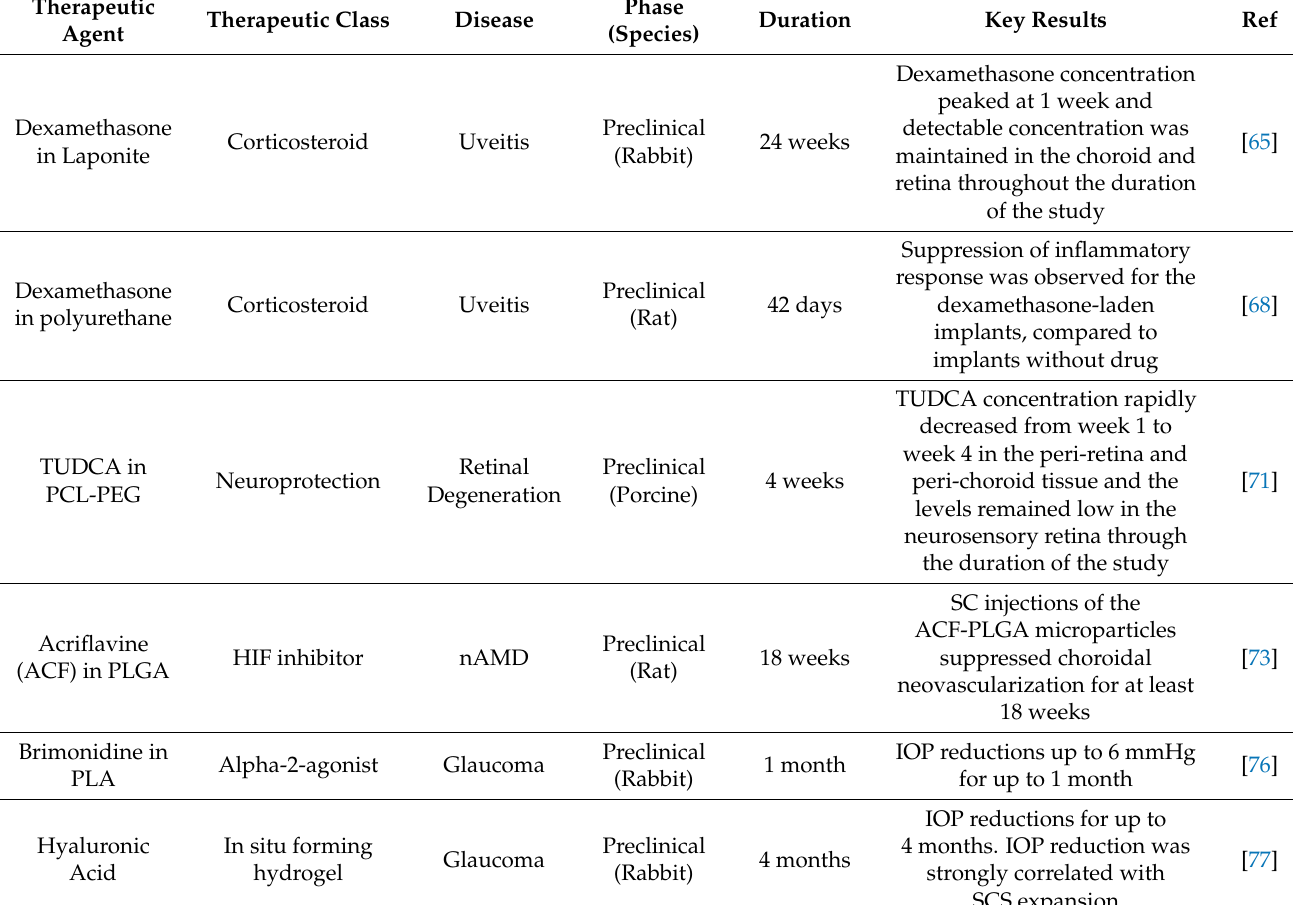
Table 2. Summary of Preclinical and Clinical Investigations of Small Molecules in Polymeric Formulation Administered into the Suprachoroidal